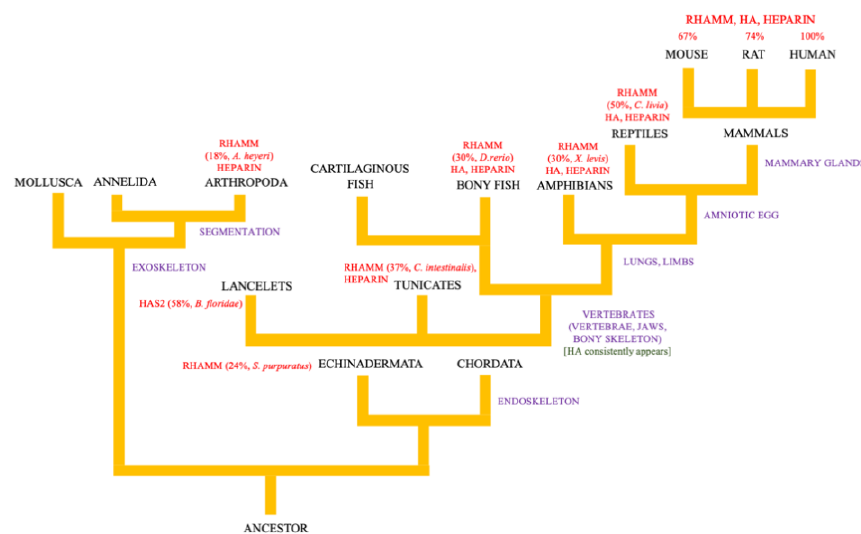
Figure 1. Evolution of RHAMM. The tree shows the appearance of hyaluronan binding ability of RHAMM with the appearance of vertebrates. More information about the evolutionary expression of RHAMM: https://www.ncbi.nlm.nih.gov/protein/?term=rhamm (accessed: 20 September 2021) and HAS2: https://www.ncbi.nlm.nih.gov/protein/?term=HAS2 (accessed: 20 September 2021) within various taxonomic groups.